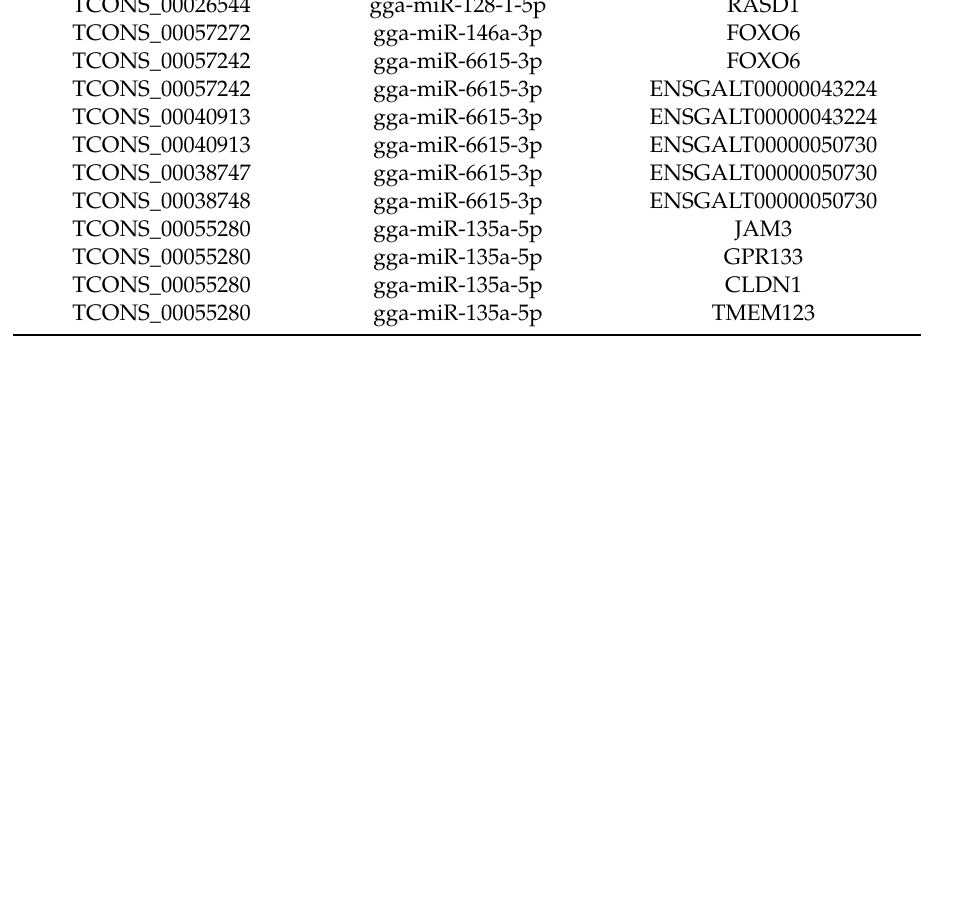
Figure 6. Visualization of crucial genes in the ceRNA network. Green, red, and blue nodes indicate lncRNAs, miRNAs, and mRNAs, respectively. Table 2. The crucial ceRNA Interactions.